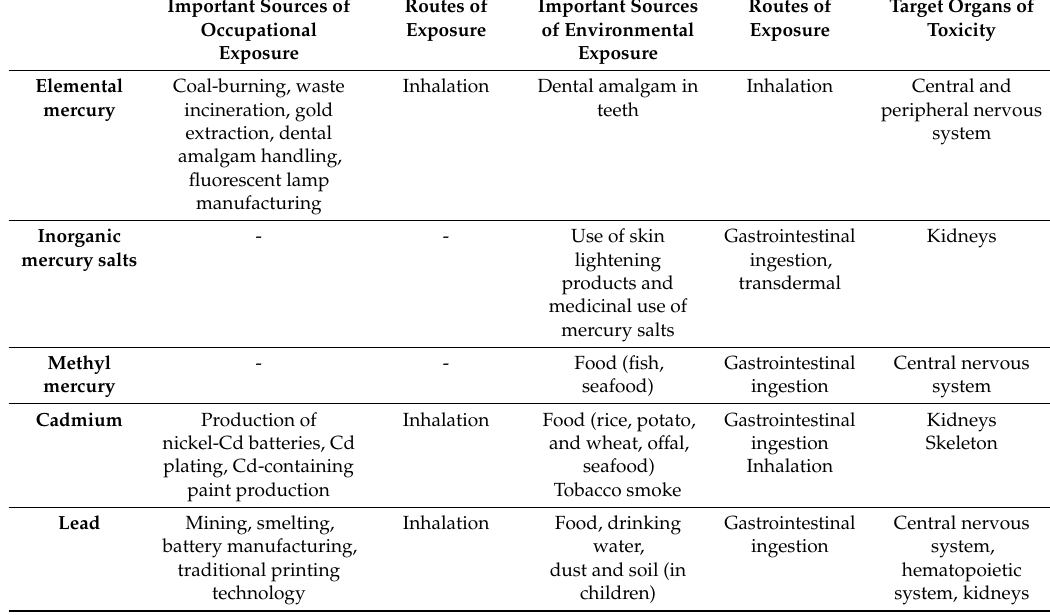
Table 2. Some exposure sources and target organs for Hg, Cd, and